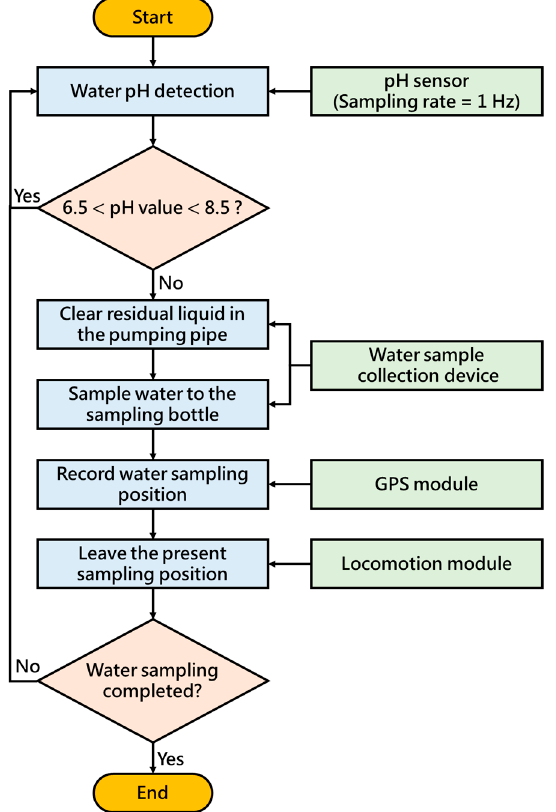
Figure 10. Water quality monitoring process.